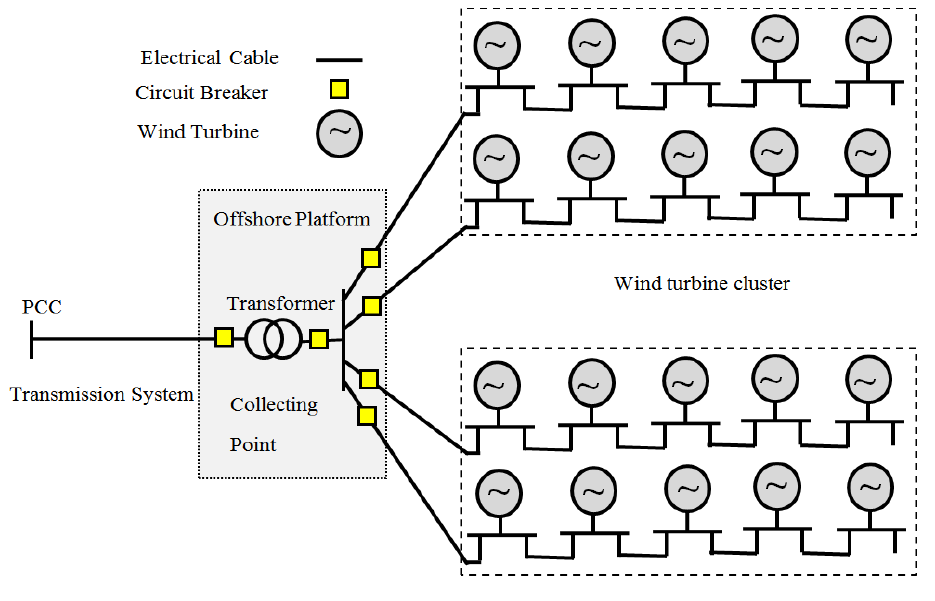
Figure 2. Schematic view of WPF electric